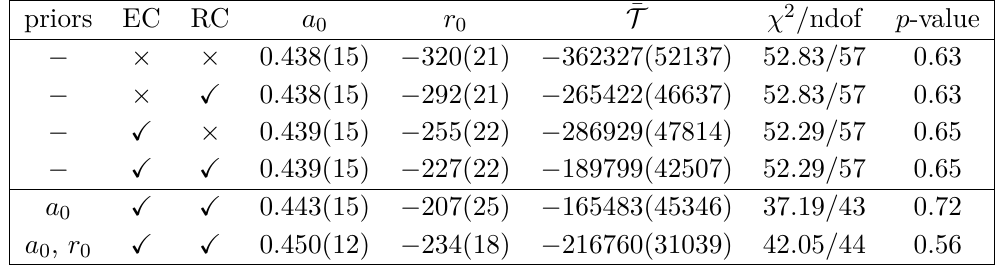
Table 6. Comparison of the results, obtained from the global energy shift fits to order L − 6 in the interval [10 , 24] with and without using priors, EC and RC. The four results above the horizontal line correspond to the fits without priors. The last two results are fits, for which the parameter(s) a 0 ( a 0 and r 0 ) obtained from the corresponding ∆ E 2 -fit within the interval [10 , 24] serve(s) as prior(s).